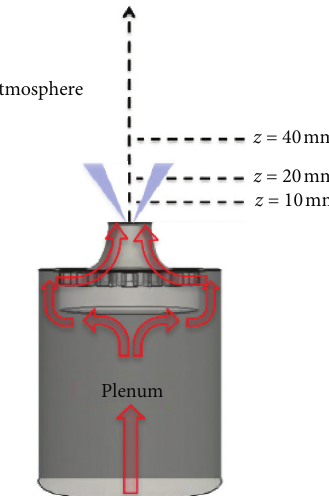
Figure 2: Experimental setup: air path in red and spray injection in blue, from